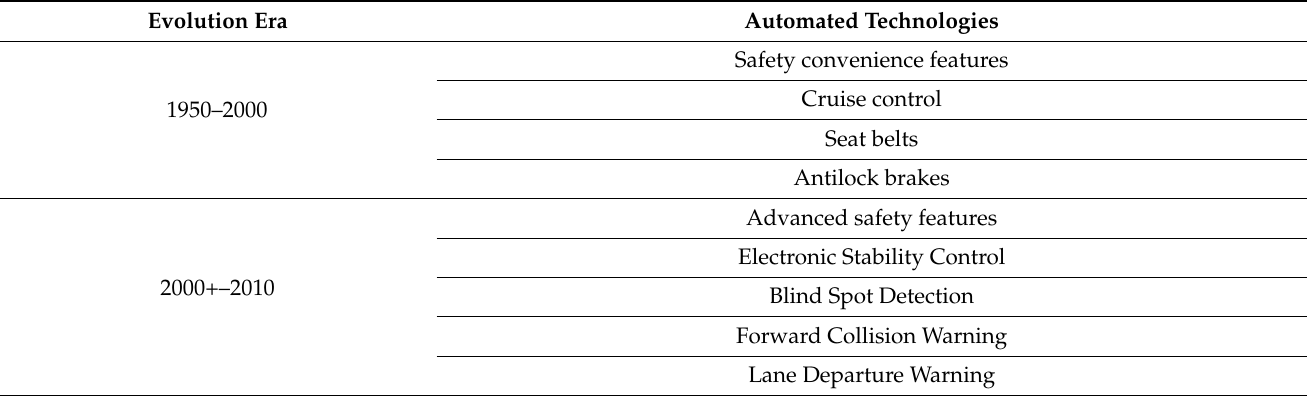
Table 1. Evolution of automated safety technologies- NHTSA